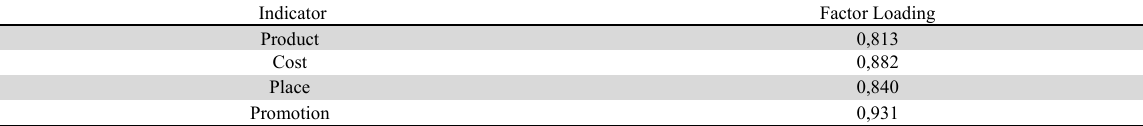
The Result of Factor Loading Mixed marketing Variable Test